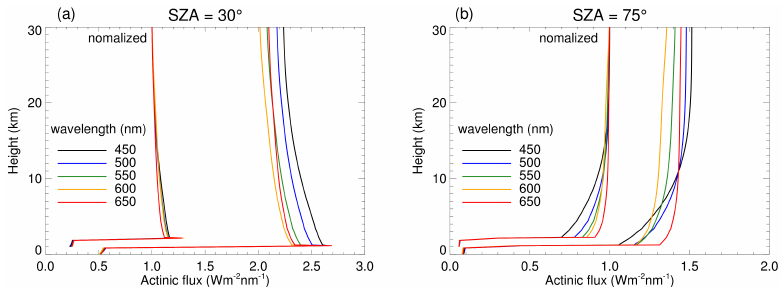
Figure 2. Simulated actinic flux profiles at wavelengths: 450, 500, 550, 600, 650 nm at SZA = (a) 30 and (b) 75 ◦ . The cloud top is at 1.3 km , cloud base is at 0.8 km , cloud optical thickness is 30. Particle size of the water cloud is 10 µ m . The aerosol optical thickness is 0.18 at 550 nm and surface albedo is 0.15. At every wavelength the normalized actinic flux profile is the simulated actinic flux profile divided by the actinic flux at 30 km . The normalized actinic fluxes are shifted 1 km up in the y-axis.